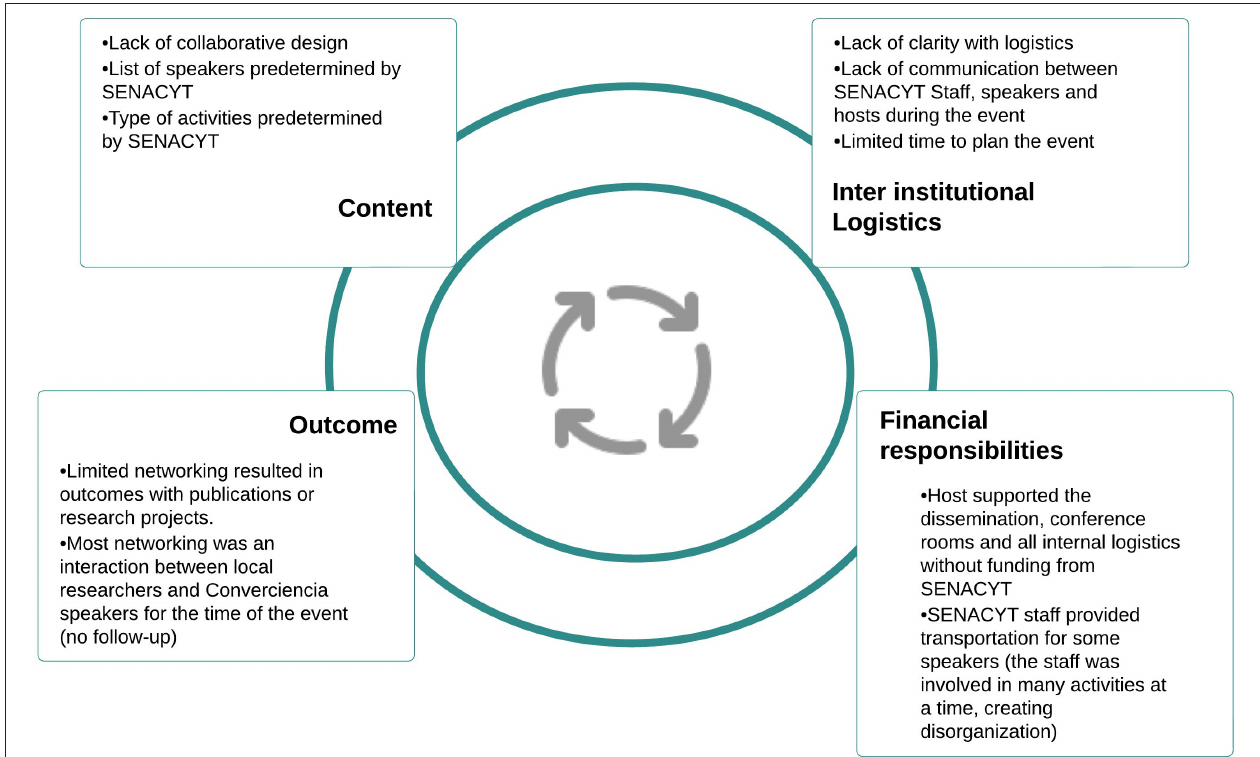
FIGURE 5 | Co-organizing Converciencia : perspective from the host institutions. Source: own